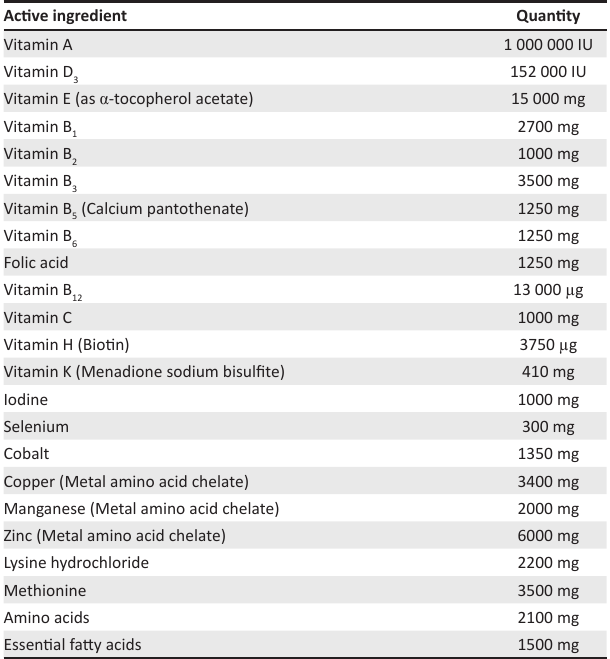
TABLE 1: Composition of Byboost™ multivitamin-multimineral supplement with added copper (per litre). Active